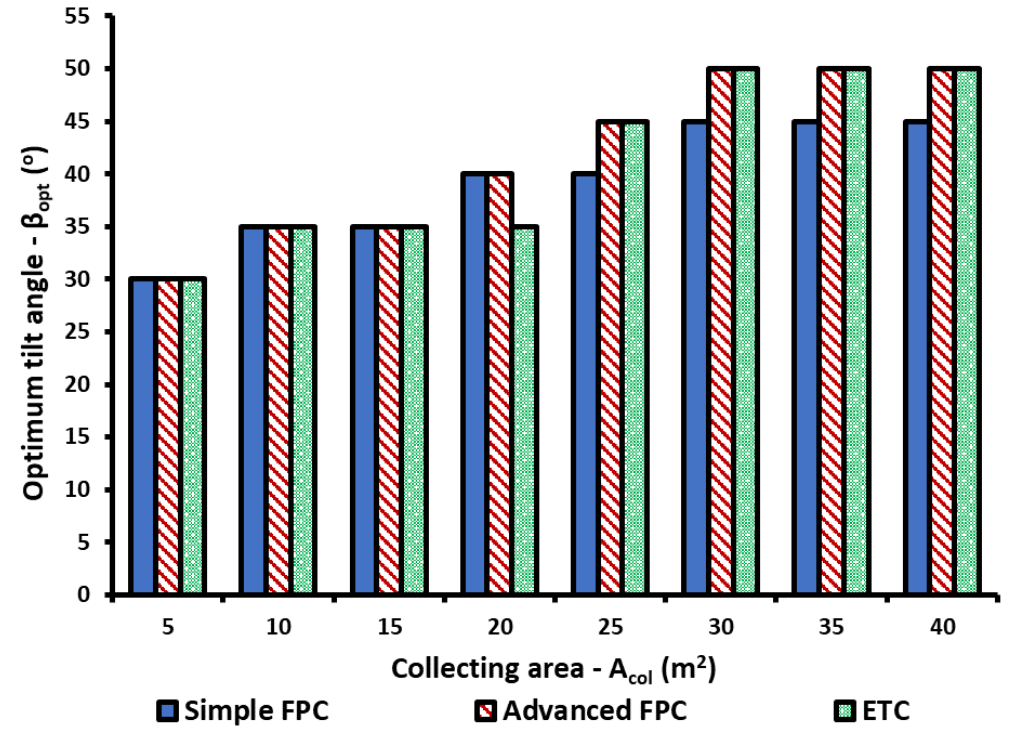
Figure 7. Optimum tilt angles aiming the solar coverage maximization for Athens.